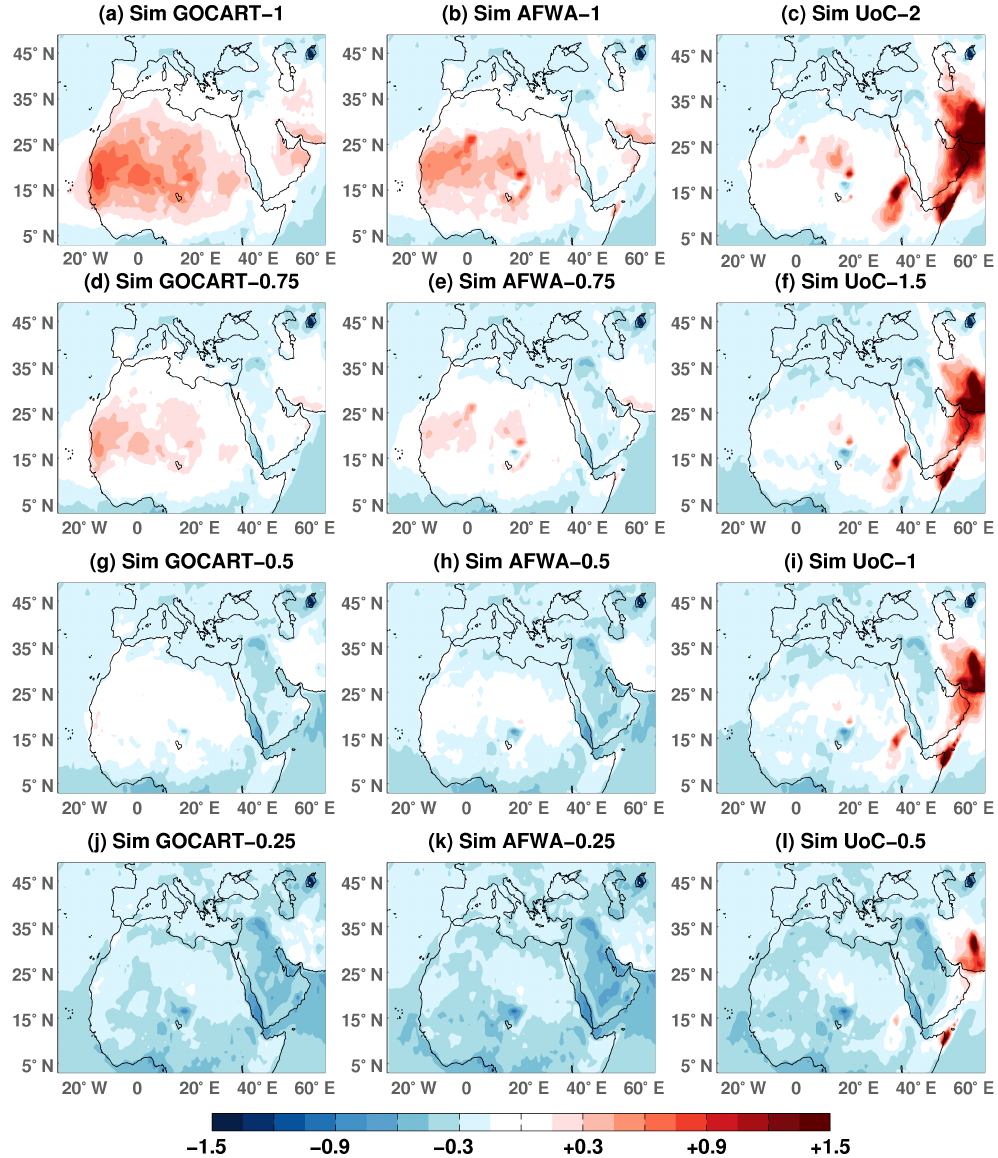
Figure 3. Differences between the modelled and observed AOD, averaged over the 6-month period. Note that different coefficients are applied for simulations using UoC compared to the ones using GOCART and